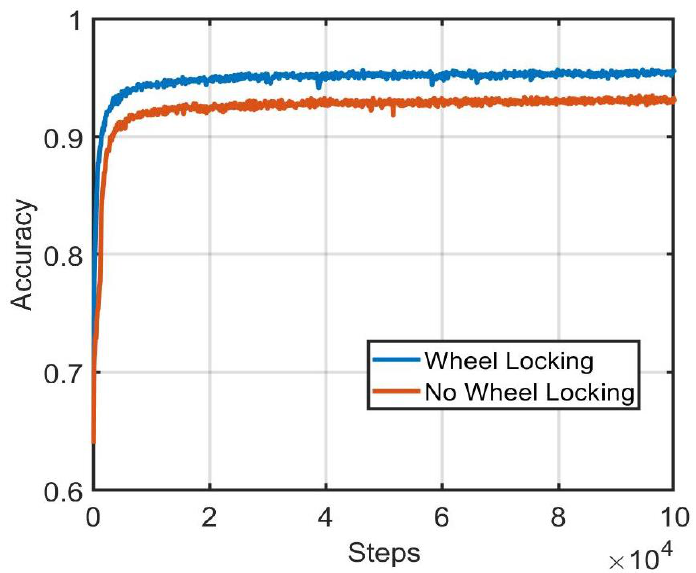
Figure 6. Comparison of training set performance during training between wheel-locking and non-wheel-locking preprocessing